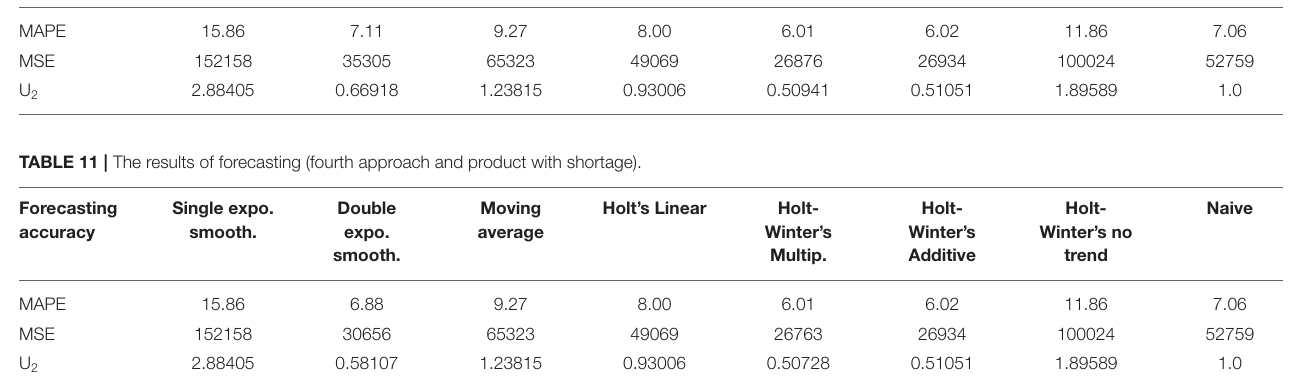
TABLE 10 | The results of forecasting (second approach and product with shortage). Forecasting accuracy